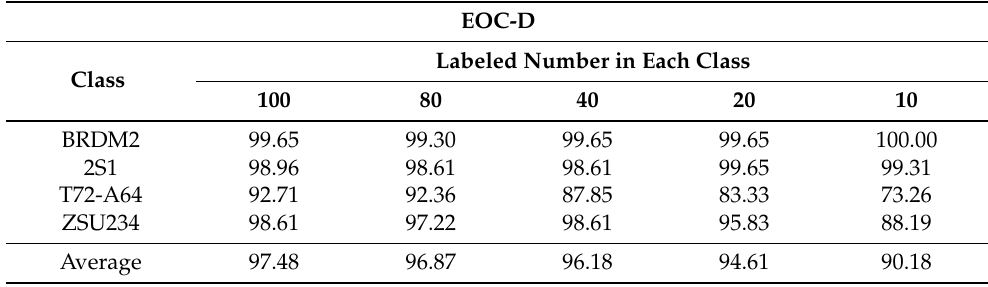
Table 5. Recognition accuracy (%) of EOC-D under different numbers of labeled images in each